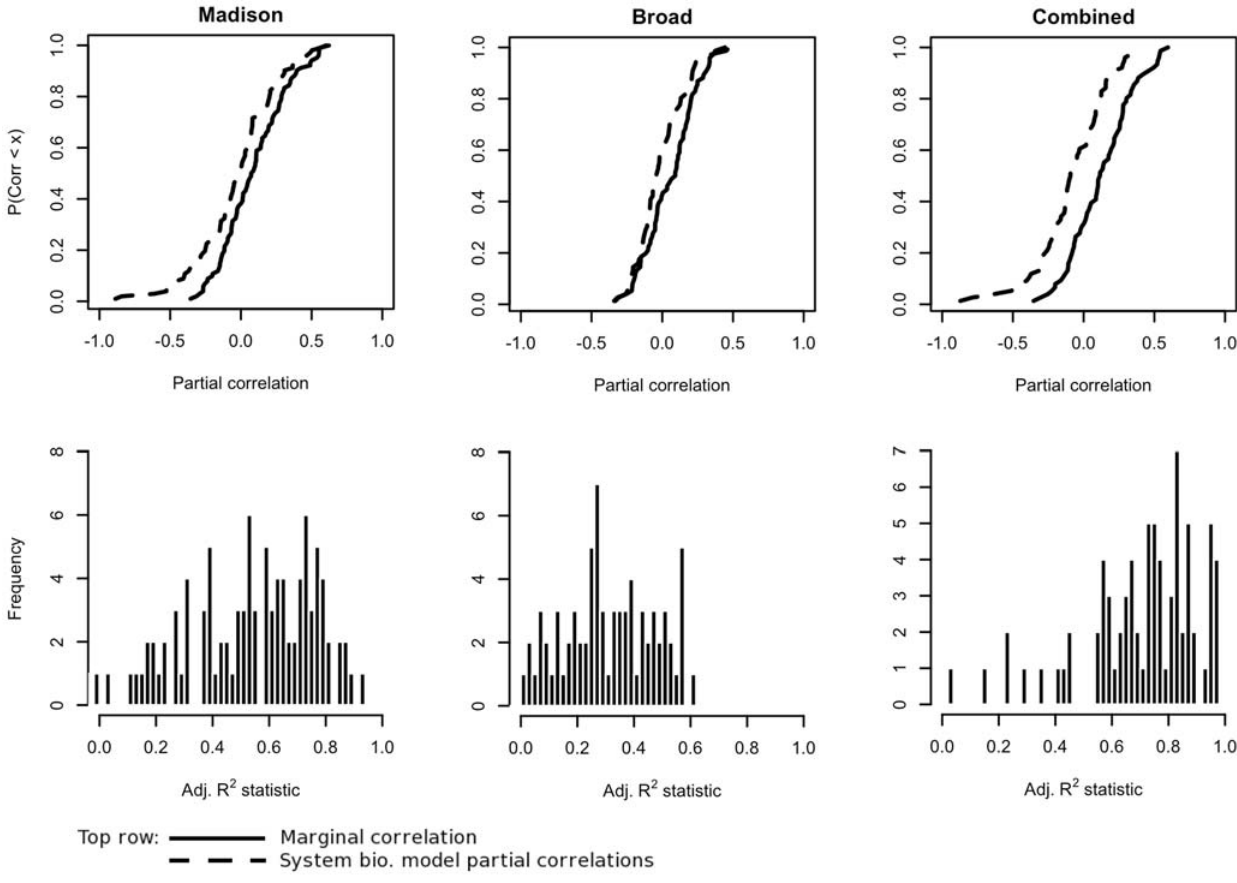
Figure 4. System biology-compensated expression level comparisons of known target pairs. Improvements in the percentages of variation in targeted mRNA expression are observed through use of the adjusted R 2 statistic. Partial correlations of proxies to targeting Ago 2 RISCs and targeted mRNAs are lower than those of m/miRNA expressions. Paired Wilcoxon tests of the hypothesis H 0 : m 0 2 m 1 =0 vs. H A : m 0 2 m 1 ? 0 were rejected for the Madison ( p =0.0135), Broad ( p =0.0186) and combined ( p , 0.0001) datasets, where m 0 and m 1 refer to mean correlations of marginal m/miRNA expression and mean partial correlations respectively.